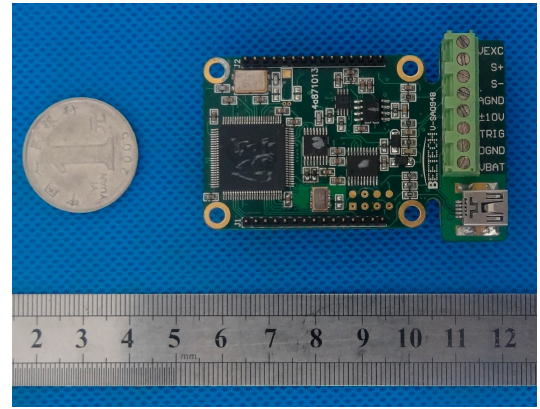
Figure 11. Sampling module.